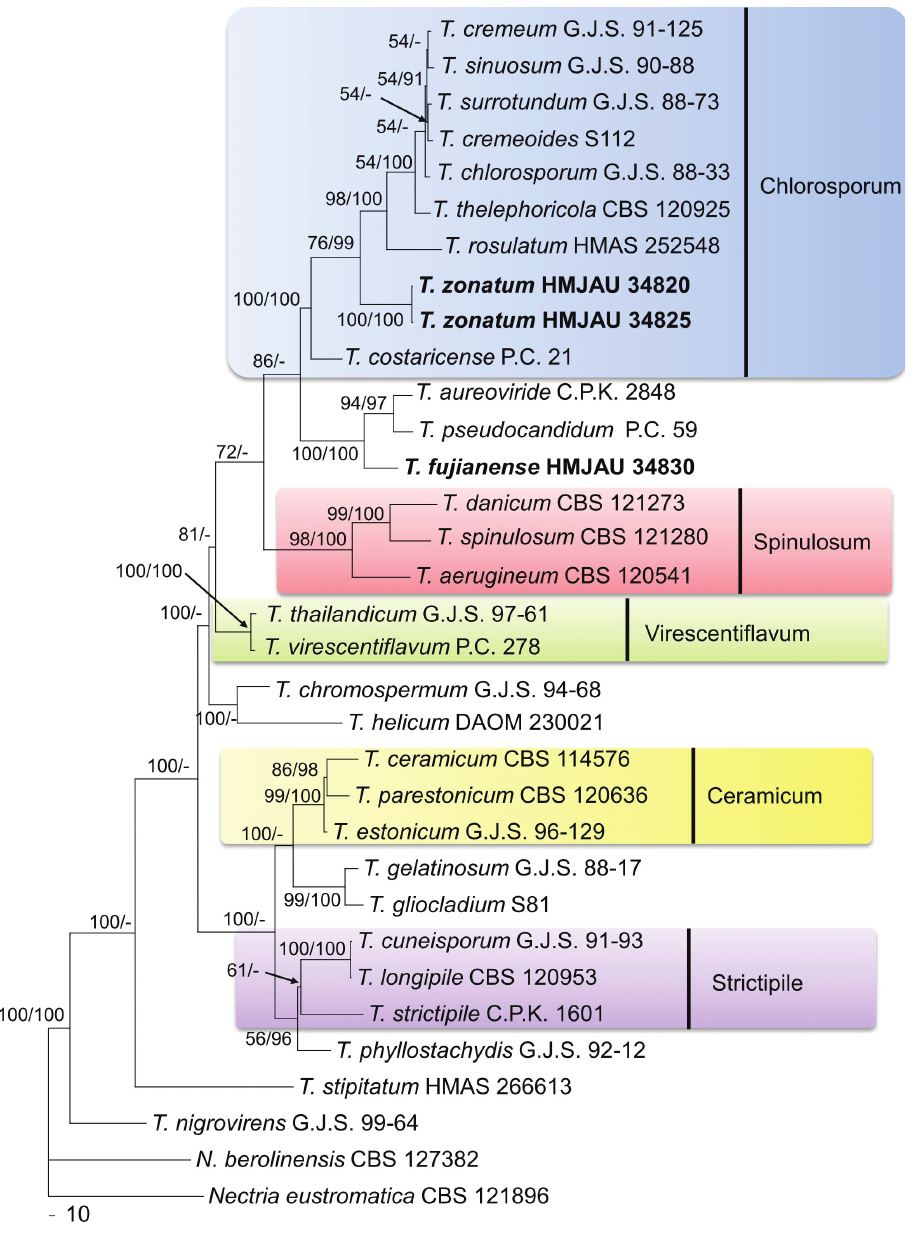
Figure 1. Maximum parsimony phylogram reconstructed from the combined squences of RPB 2 and TEF 1- α . MPBP above 50% (left) and BIPP above 90% (right) are indicated at the nodes. Trichoderma aureoviride , T. candidum and T. fujianense form an independent line- age with high statistical support (MPBP/BIPP = 100%/100%), which still remains unnamed (Chaverri and Samuels 2003, Jaklitsch